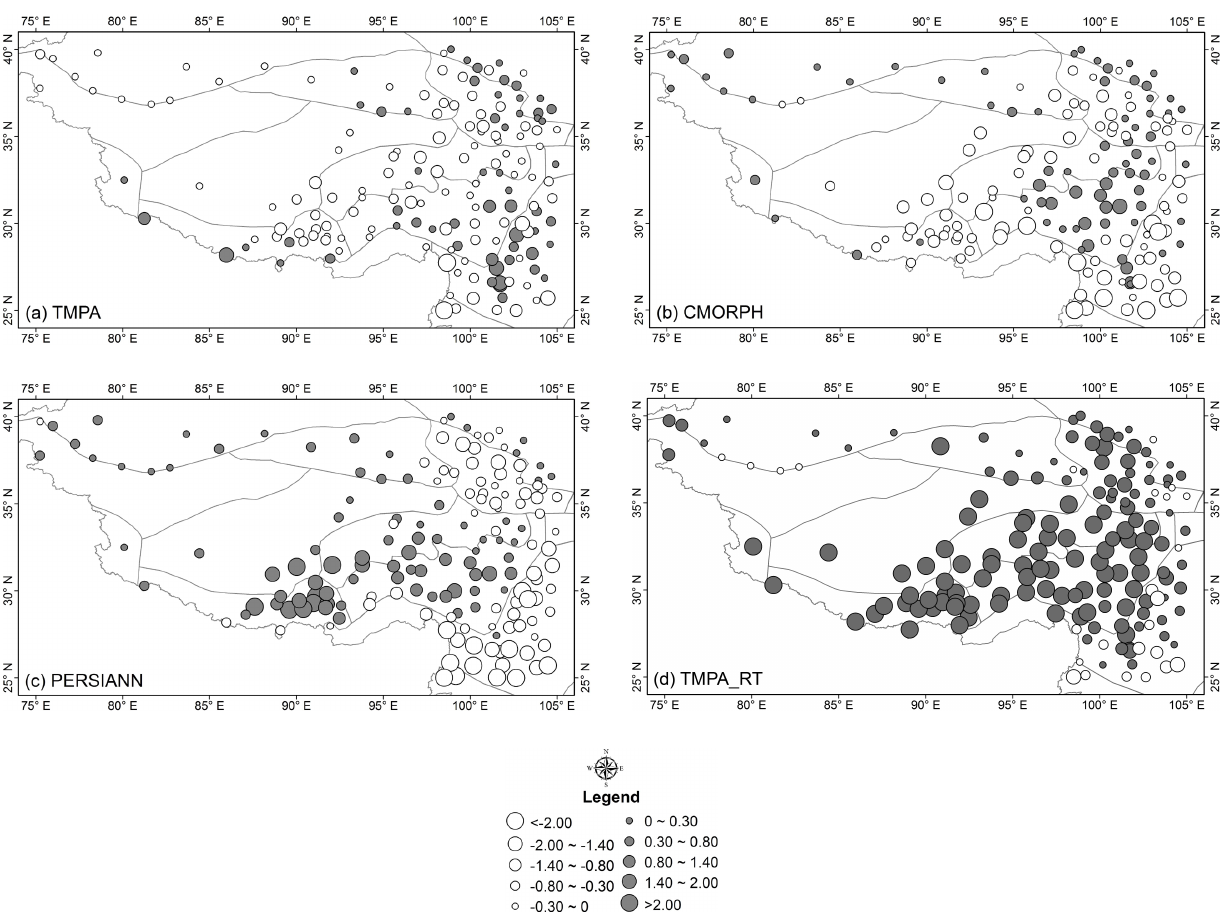
Fig. 6. The spatial pattern of biases= S − G (mmday − 1 ) between gauge-based daily precipitation and that derived from satellite products from May to October during